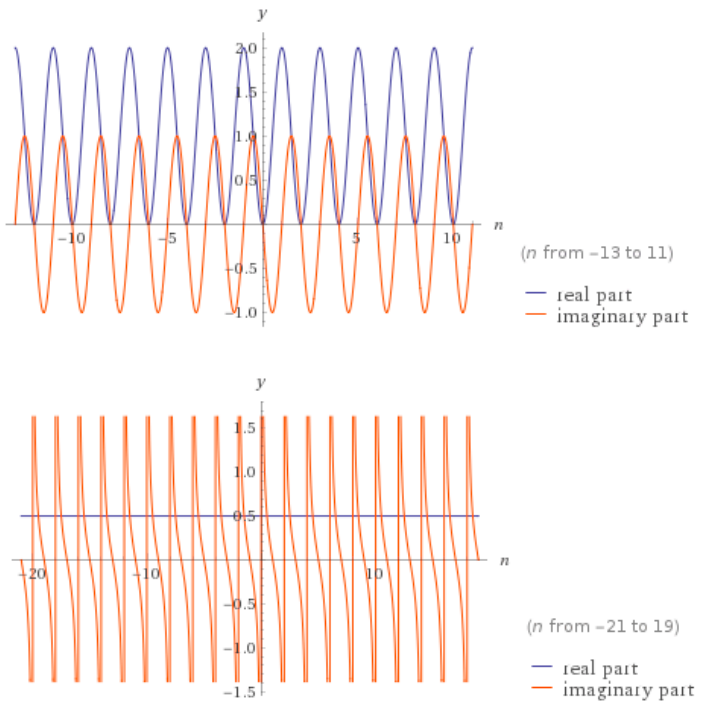
Figure 1. The first graph is ( 1 + ( − 1 ) n + 1 ) , and the second is 1/ ( 1 + ( − 1 ) n + 1 )